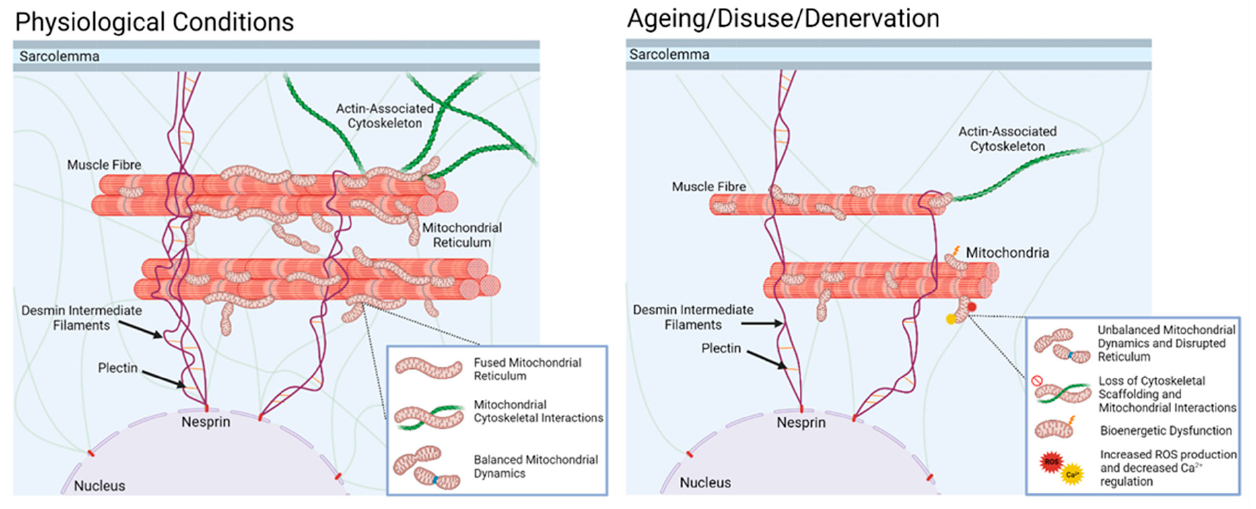
Figure 4. In normal physiology, skeletal muscle mitochondria are maintained in a complex reticulum by interactions with the actin cytoskeleton and intermediate filaments. This condition is associated with balanced mitochondrial dynamics, high capacity for energy production, low mitochondrial peroxide production, and minimal apoptotic signalling. With disuse of the muscle, or, as we speculate, denervation associated with ageing, the supportive interactions with the cytoskeleton are lost, leading to disruption of the reticulum, a change in mitochondrial dynamics (increased fission, reduced fusion, and increased mitophagy), and increased degenerative signalling through reduced energy production, increased mitochondrial peroxide, and increased apoptotic signalling.